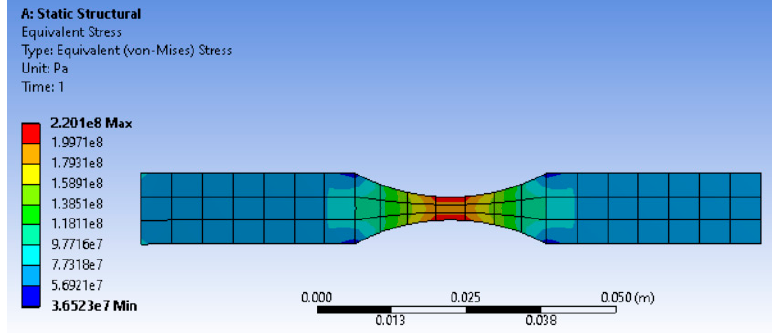
µ m of displacement at the end.